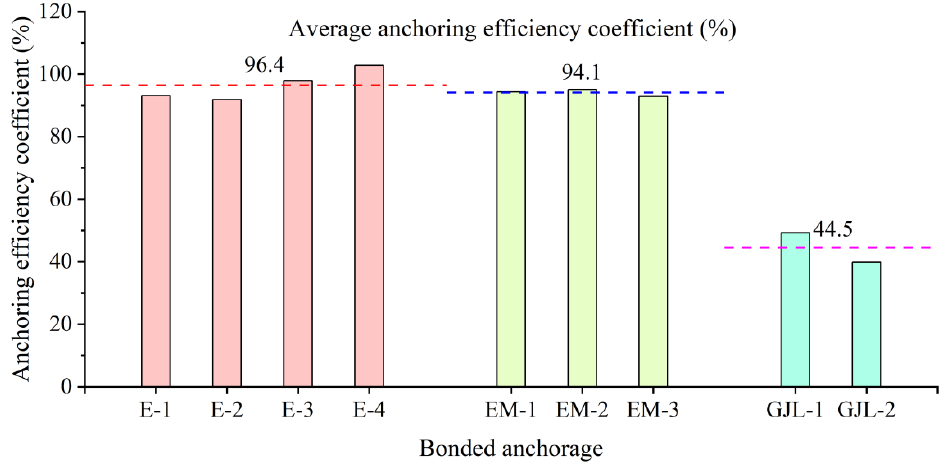
Figure 18. Comparison of anchoring efficiency coefficients of different bonding medium.